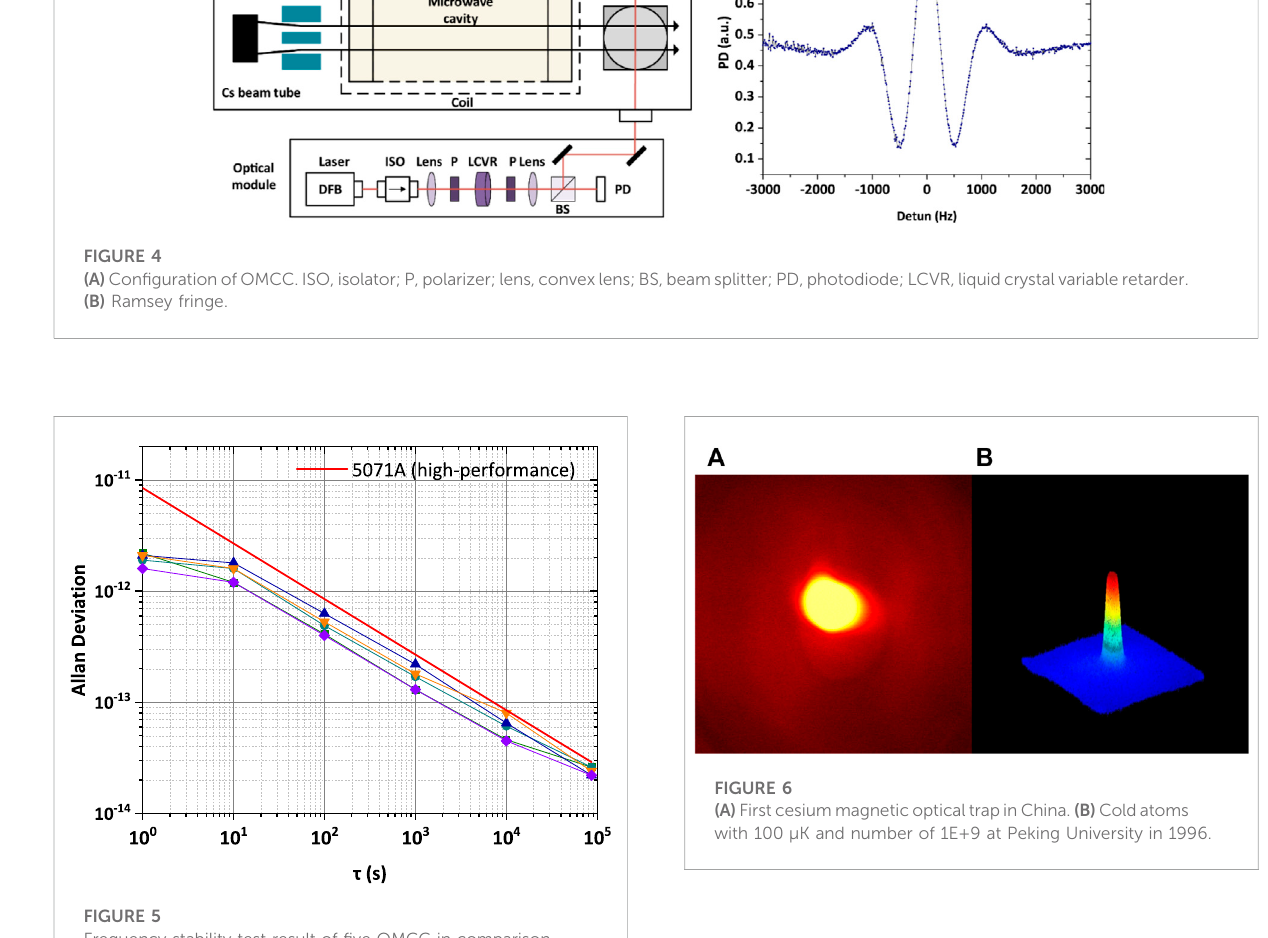
FIGURE 5 Frequency stability test result of fi ve OMCC in comparison with the high-performance version of 5071A.